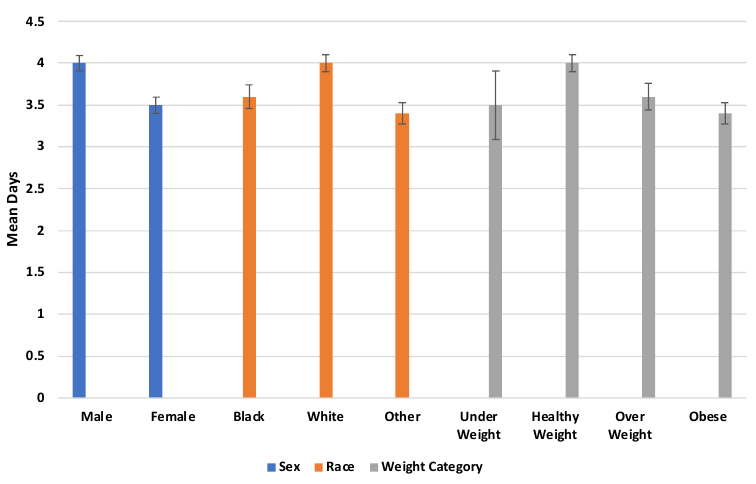
Figure 1. Mean self-reported days of 60 minute physical activity (PA) per week by group, with comparison by t -test for sex ( p < 0.0001), and ANOVA for race ( p < 0.0001), and weight ( p < 0.0001) categories. Table 3. Count (percent) of participants reporting 60 min of self-reported PA on at least one, five or seven day(s) per week ) by schools ’ PE and PA opportunities, sex, ethnicity, and weight categories.